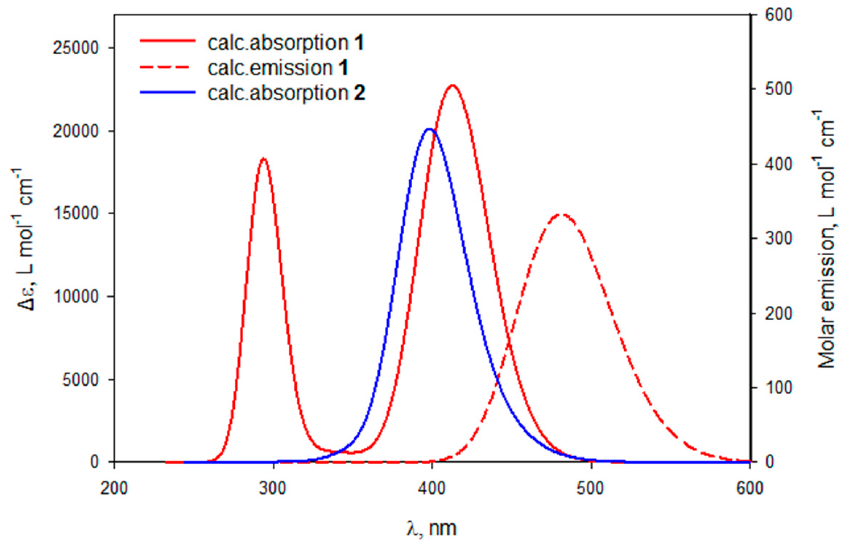
Figure 9. Calculated UV-Vis absorption (solid lines) and emission (dashed line) spectra of complexes 1 (red) and 2 (blue) with a gaussian broadening (FWHM = 3000 cm − 1 ); TD-DFT/PBE1PBE/TZVP. The first calculated allowed transition in complex 1 , occurring at 413 nm (SI), cor- responds to a HOMO → LUMO excitation of π – π * type (Figure 10 left), HOMO being based mainly on the pyridine and benzene rings, while LUMO is mainly delocalized on the BTD unit, with a large participation of the thiadiazole ring. The corresponding calculated emission wavelength values amounts to 478 nm, hence blue-shifted compared to the experimental value measured in the solid state but in agreement with the value of 467 nm for the emission in CH 2 Cl 2 solution (Figure S19). One can thus hypothesize that the red-shift for the absorption/emission bands observed in the solid state is the consequence of intermolecular π – π stacking interactions, all the more since HOMO and LUMO are localized on the π system involved in the corresponding electronic transition. In complex 2 the highest four occupied orbitals, that is, from HOMO–3 to HOMO, are in-phase and out-of-phase combinations of hfac based orbitals, while the LUMO has a similar distribu- tion as in complex 1 , namely on the BTD unit, with a large participation of the thiadiazole ring. Consequently, the first four singlet excited states, which are HOMO–n → LUMO excitations ( n = 0–3), present very weak oscillator strengths. The first intense absorption band is described by a HOMO–4 → LUMO excitation, as shown by the electron density difference (EDD) between the 5th excited state and the ground state (Figure 10 right) and corresponds, as the S 1 -S 0 transition in complex 1 , to a charge transfer from the benzene- dipyridine skeleton to thiadiazole. The calculated wavelength value for this absorption is 397 nm, thus slightly blue-shifted compared to 1 , yet remaining consistent with the experimental absorption band measured in CH 2 Cl 2 solution occurring at λ max = 387